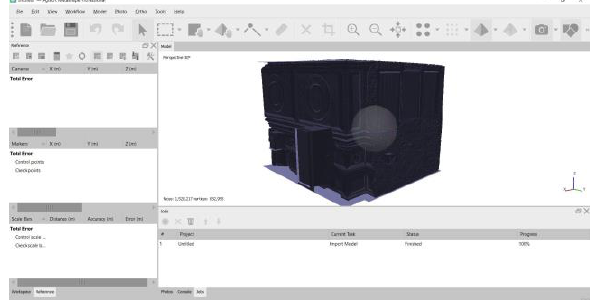
Figure 5. Mesh of the Small Sacristy, obtained from the laser scans and imported into Agisoft